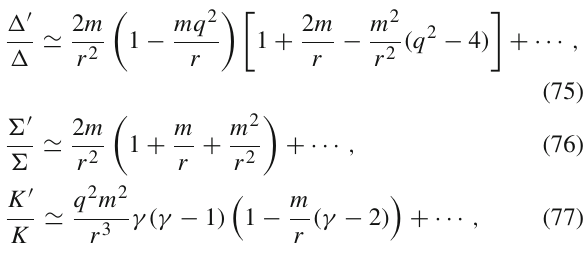
Fig. 12 Variationinthebendingangle δ versus x isplottedforthecom- pact object VelaX-1. The star is considered for the cases of uncharged stationary (ω (cid:8)= 0 ) ,staticcharged ( q (cid:8)= 0 ) andstaticuncharged ( q = 0 )